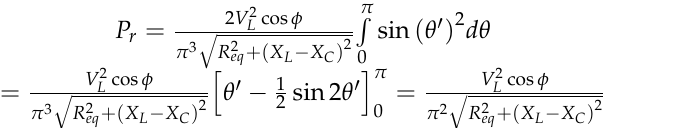
Equation (18) is substituted in (20):